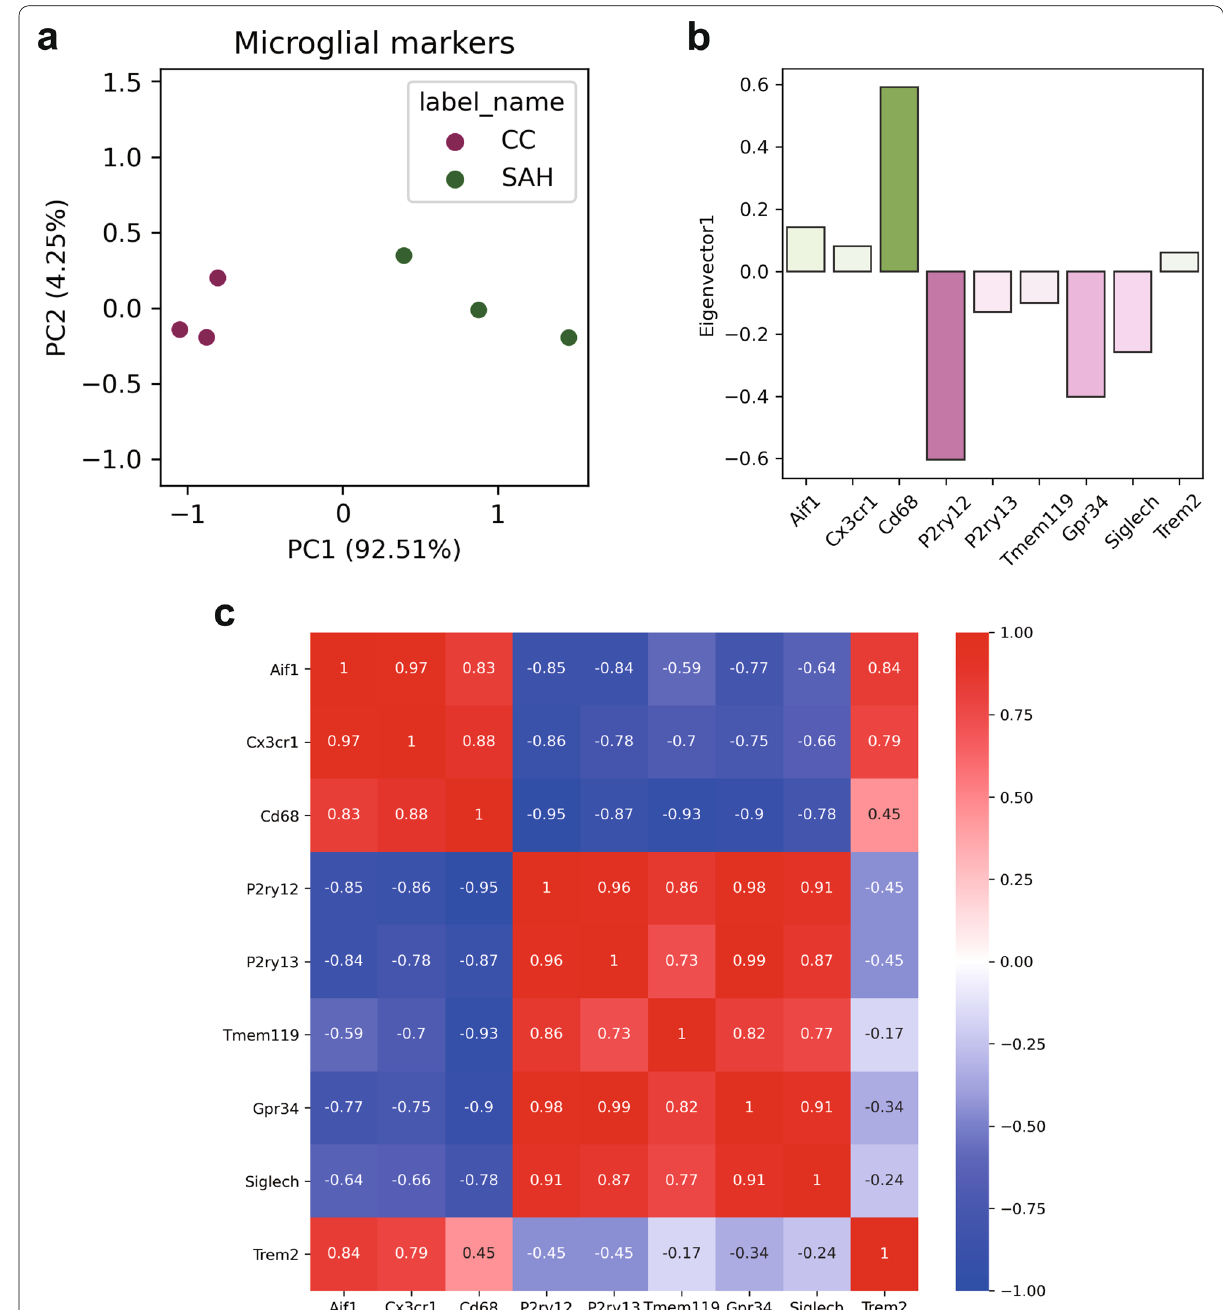
Fig. 2 Expression patterns of microglial markers. a A scatterplot of microglial marker expression. The expression matrix of the microglial markers (Aif1, Cx3cr1, Cd68, P2ry12, P2ry13, Tmem119, Gpr34, Siglech, and Trem2) was decomposed into principal components (PC1, 2, … n, where n is the rank of the matrix). The horizontal axis represents the PC1 score, and the vertical axis represents the PC2 score. b The four genes (Aif1, Cx3cr1, Cd68, Trem2) had positive loadings in eigenvector 1, which suggested that the PC1 score increased as the expression levels of the four genes increased. c A heatmap of the correlation matrix of microglial marker